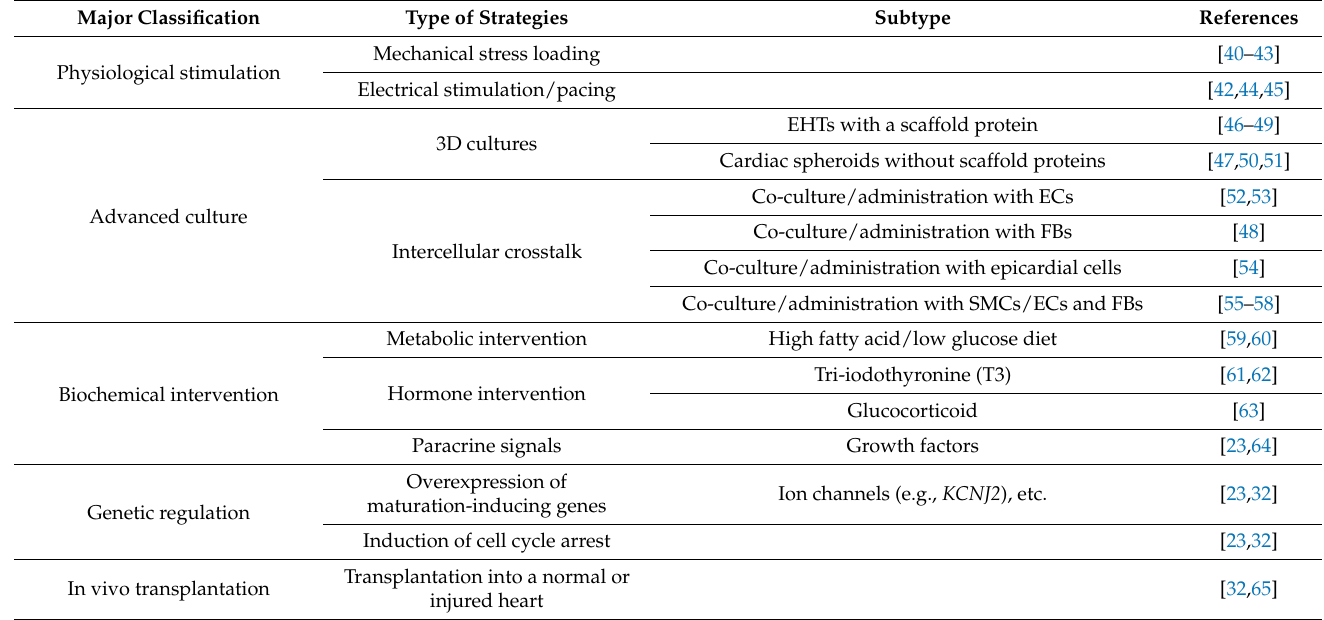
Table 1. Tissue-engineeringstrategies forpromoting maturationin hPSC-CMs. 3D, three-dimensional; EC, endothelial cell; EHT, engineered heart tissue; FB, fibroblast; SMC, smooth muscle